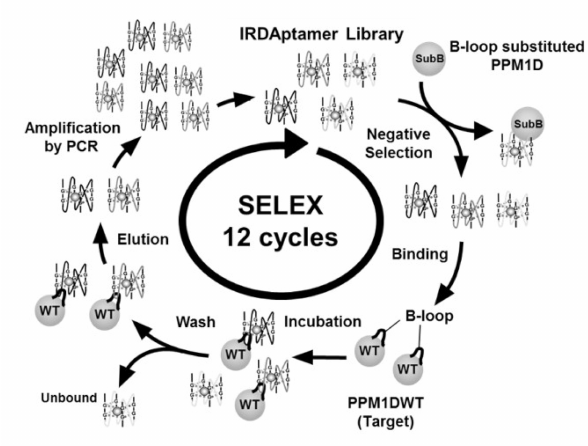
Figure 1. Scheme of screening of ion-responsive DNA aptamers targeting B-loop of PPM1D from the designed IRDAptamer library.